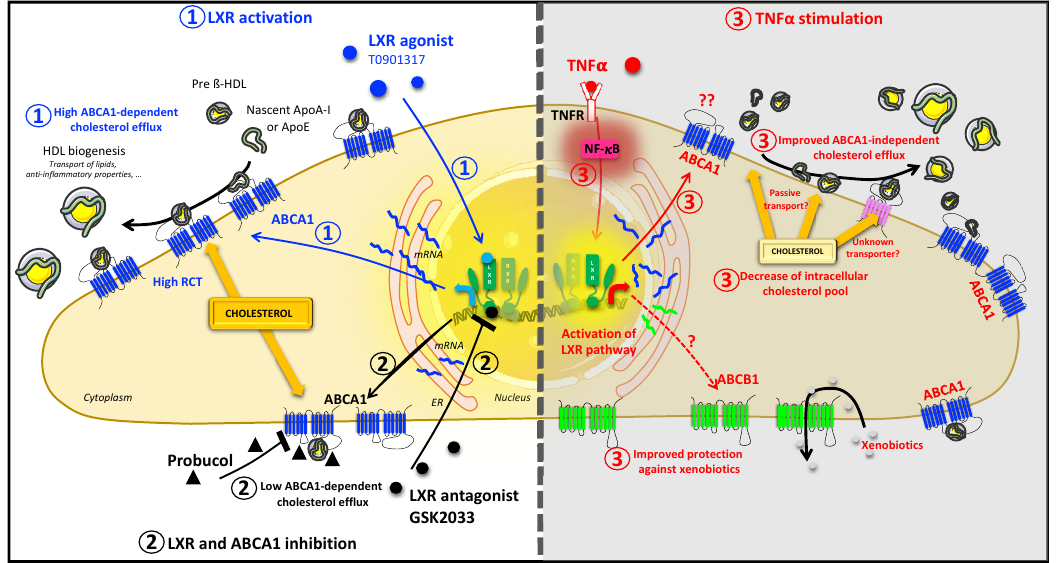
Figure 10. TNFα induces an LXR / ABCA1 independent cholesterol efflux. In HBP, T0901317 ( LXR agonist) activates the LXR pathway which upregulates ABCA1 gene and protein expression. Conse- quently, the reverse cholesterol transport (RCT) mediated by ABCA1 is increased (1). However, LXR pathway inhibition via the antagonist GSK2033, suppress ABCA1 expression and consequently in- hibits the T0901317- ABCA1 -mediated cholesterol efflux (2). The same effect was reported using Probucol, the ABCA1 inhibitor (2). Under inflammatory stimulation, TNFα activates the NF - κB pathway and the LXR pathway (3). As in the T0901317 case, activation of the LXR pathway upreg- ulates ABCA1 and correlates with an increased cholesterol efflux (3). Contrary to the T0901317 ’ s case, neither LXR inhibition with GSK2033, nor ABCA1 inhibition with Probucol, were able to sup- press the TNFα -induced cholesterol efflux, suggesting that this efflux is LXR / ABCA1 -independent. The TNFα -induced cholesterol efflux is possibly related to another transporter not identified in our study or to a passive transport, a direct lipid exchange between the plasma membrane and the cell surrounding lipid acceptors. In parallel, TNFα stimulation upregulates ABCB1 gene and protein expression (3). The activity of this protein is increased, and, consequently, HBP protection against xenobiotics is improved (3). Thus, TNFα induces a n LXR / ABCA1 -independent cholesterol efflux and xenobiotics efflux in HBP, shedding light on the possible role of pericytes in diseases progres- sion. 5. Materials and Methods 5.1. Human Brain Pericytes (HBP) Human brain pericytes (HBP) were isolated from a patient who had suddenly died from a heart attack [28]. Study protocol for human tissue was approved by the ethics com- mittee of the Medical Faculty (IRB#: H18-033-6), University of Yamaguchi Graduate School, and was conducted in accordance with the Declaration of Helsinki, as amended